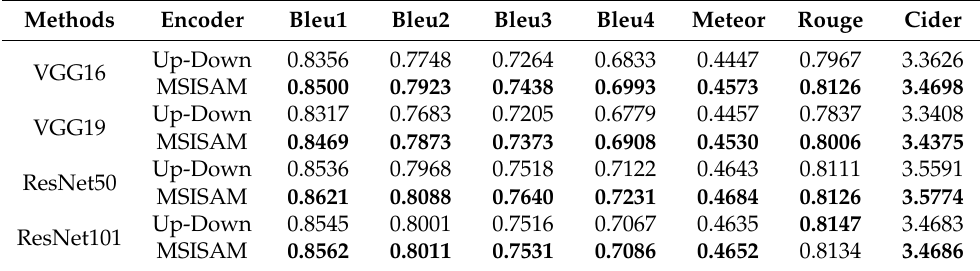
Table 8. Comparison experiments on the UCM-Captions data set [33] based on different CNNs.